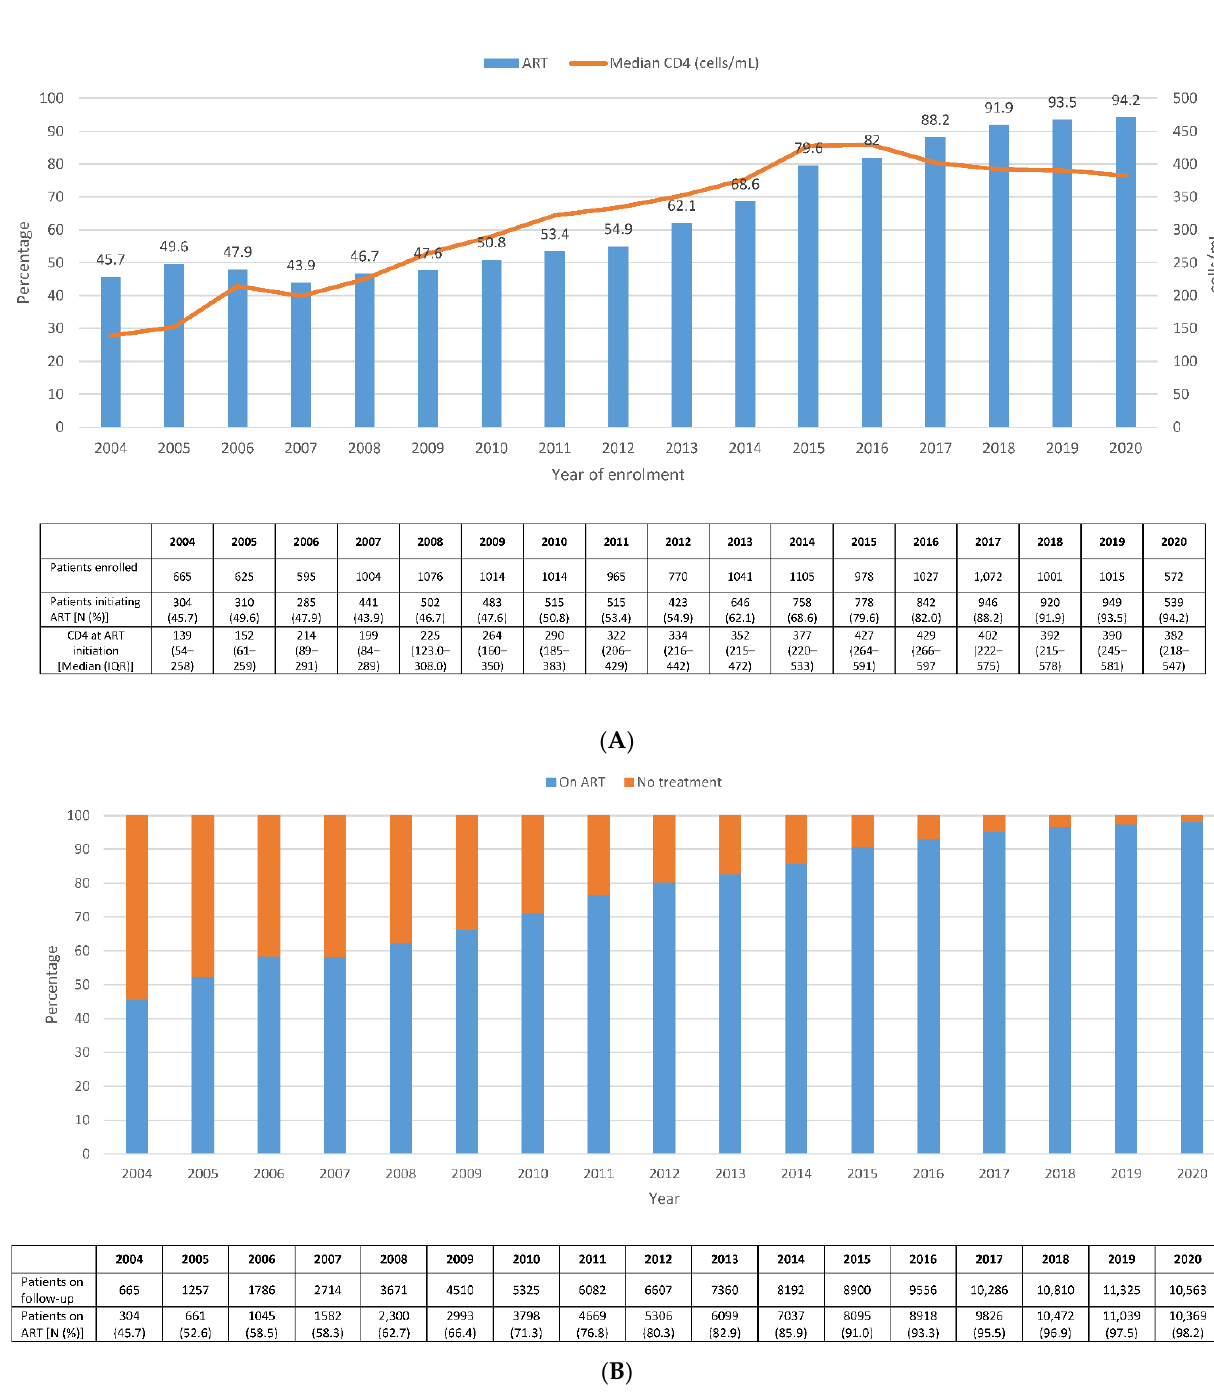
Figure 1. Temporal trends in the percentage of ( A ) patients initiating ART according to the year of enrollment in CoRIS and ( B ) patients on ART treatment, 2004–2020.